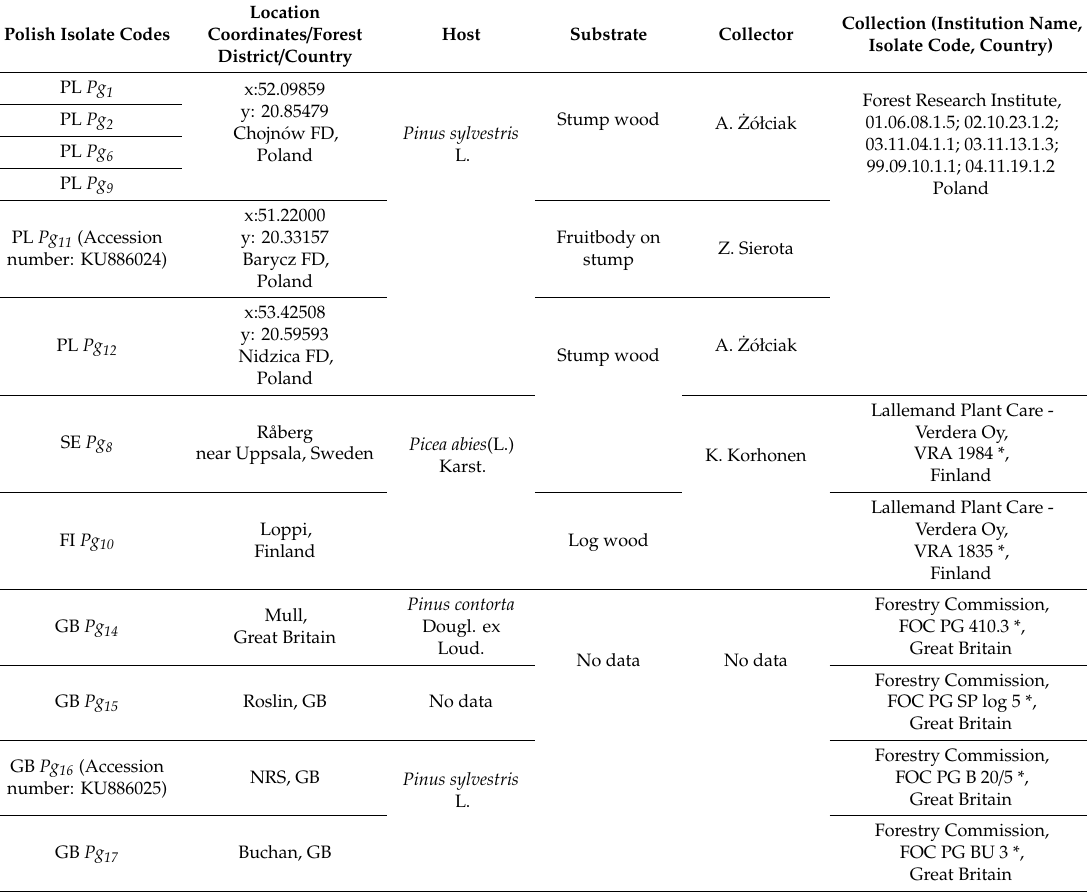
Table 1. List of P. gigantea isolates used in the study. Polish Isolate